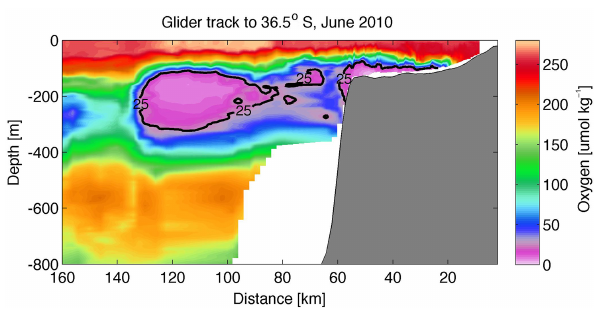
Figure 5. Vertical distributions of dissolved oxygen (µmolkg − 1 ) in a cross-shore section at 36.5 ◦ S near the time of eddy formation (June 2010). Black line indicates the isoline of 25µmolkg − 1